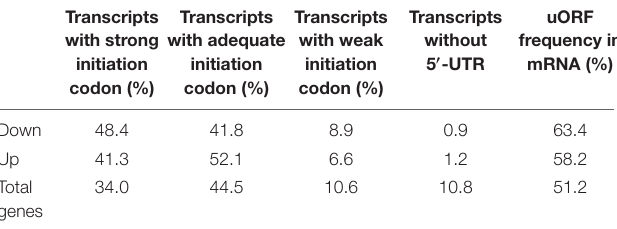
TABLE 5 | The frequency of initiation codon and uORFs for cold-AtGCN1 down-translated or up-translated genes. Transcripts Transcripts Transcripts Transcripts uORF with strong with adequate with weak without frequency in initiation initiation initiation 5 (cid:48) -UTR mRNA codon (%) codon (%) codon (%)